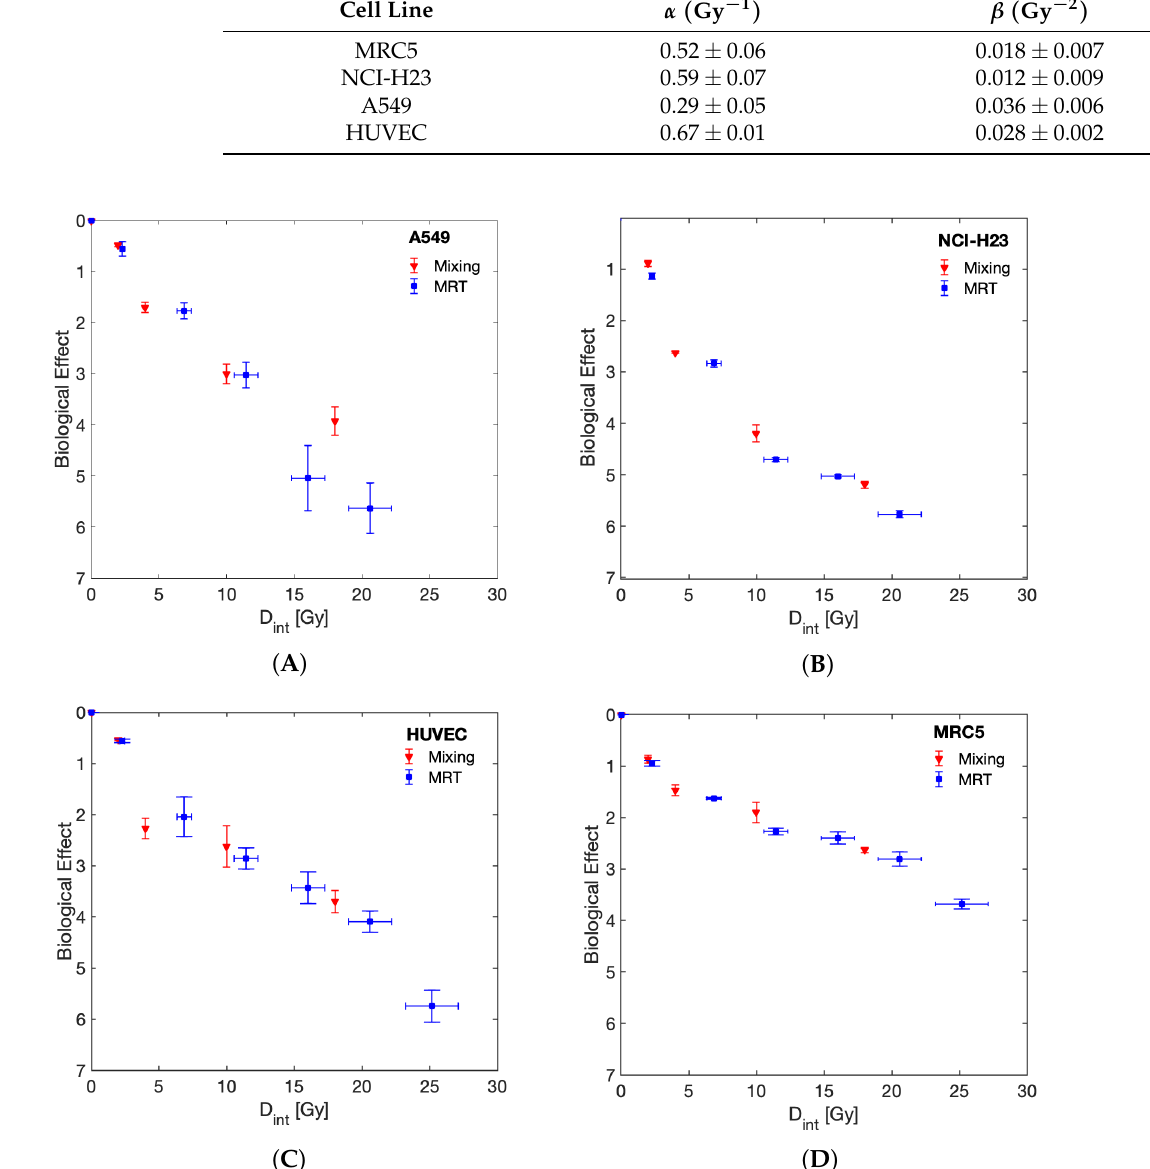
Figure 4. Comparing the biological effect of MRT and dose mixing experiments as a function of integral dose. Survival curves are shown for tumour ( A ) A549, ( B ) NCI-H23 and normal ( C ) HUVEC and ( D ) MRC-5 cell